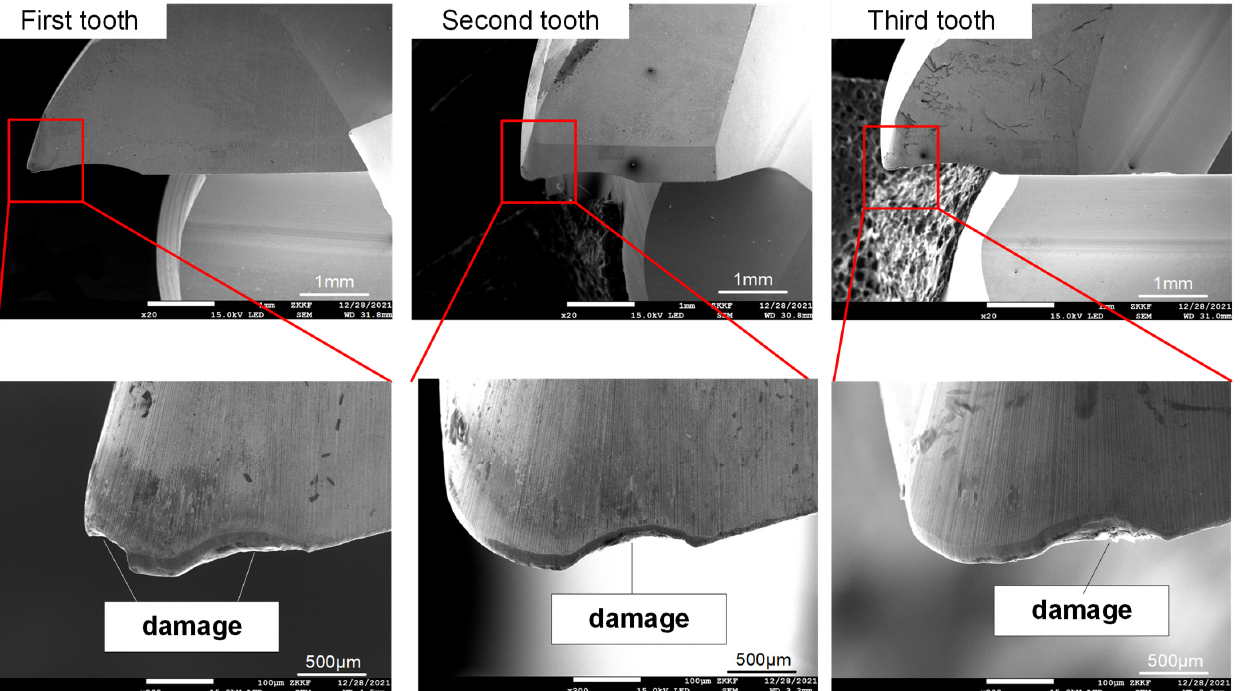
Figure 13. SEM images of cutting-edge wear in the case of CCF-10.